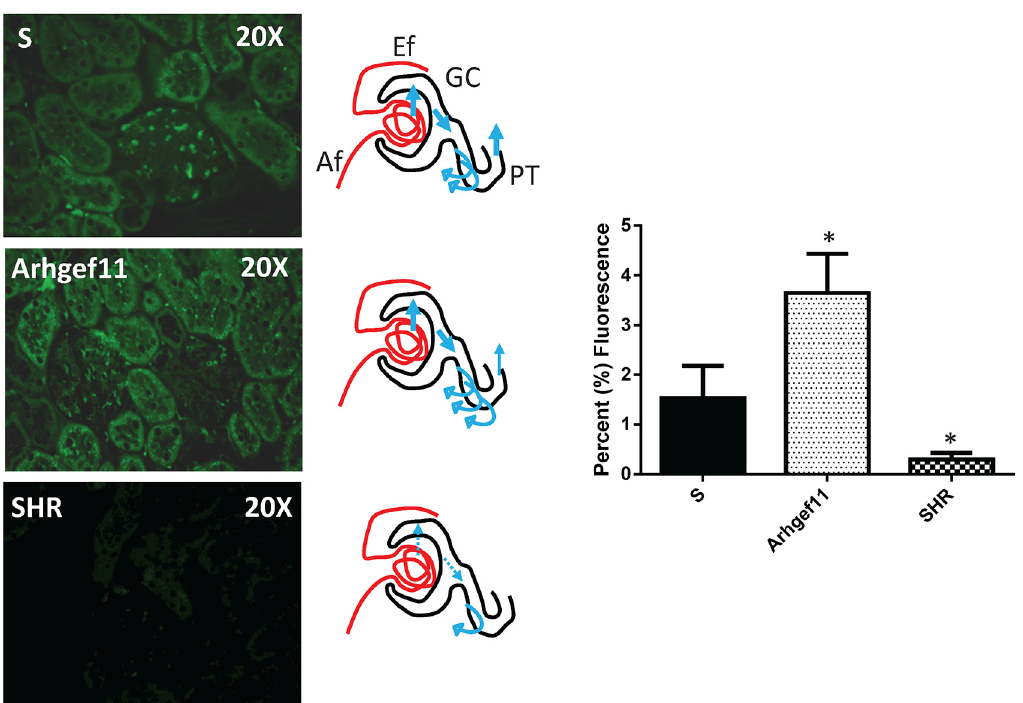
Fig 9. In vivo assessment of albumin re-uptake by infusion via FITC-albumin and immunofluorescence imaging. FITC-labeled albumin was infused in S, Arhgef11-congenic and SHR (n = 5 – 6 per group) at a rate of 100 ul/min for 15 min. Subsequently, kidneys were collected, fixed in a 10% buffered formalin solution, processed and sectioned, and imaged. Threshold image analysis was used to measure the degree of fluorescence in the kidney from each strain (n = 2 sections per kidney and 10 – 15 images per section). Kidneys from Arhgef11-congenic exhibited an increase in tubular fluorescence/punctate regions of active albumin uptake compared to kidney from S. Fluorescence in SHR kidney was low as little albumin is filtered and remains in glomerular vasculature. Af, afferent arteriole; Ef, efferent arteriole; GC, glomerular capillary, PT, proximal tubule. The thicker the blue arrow the more protein that occurs in the ultrafiltrate and enters the proximal tubule/urine. The number of curved arrows denote active reuptake of filtered protein. * p < 0.05 versus S. Error bar are +SE.